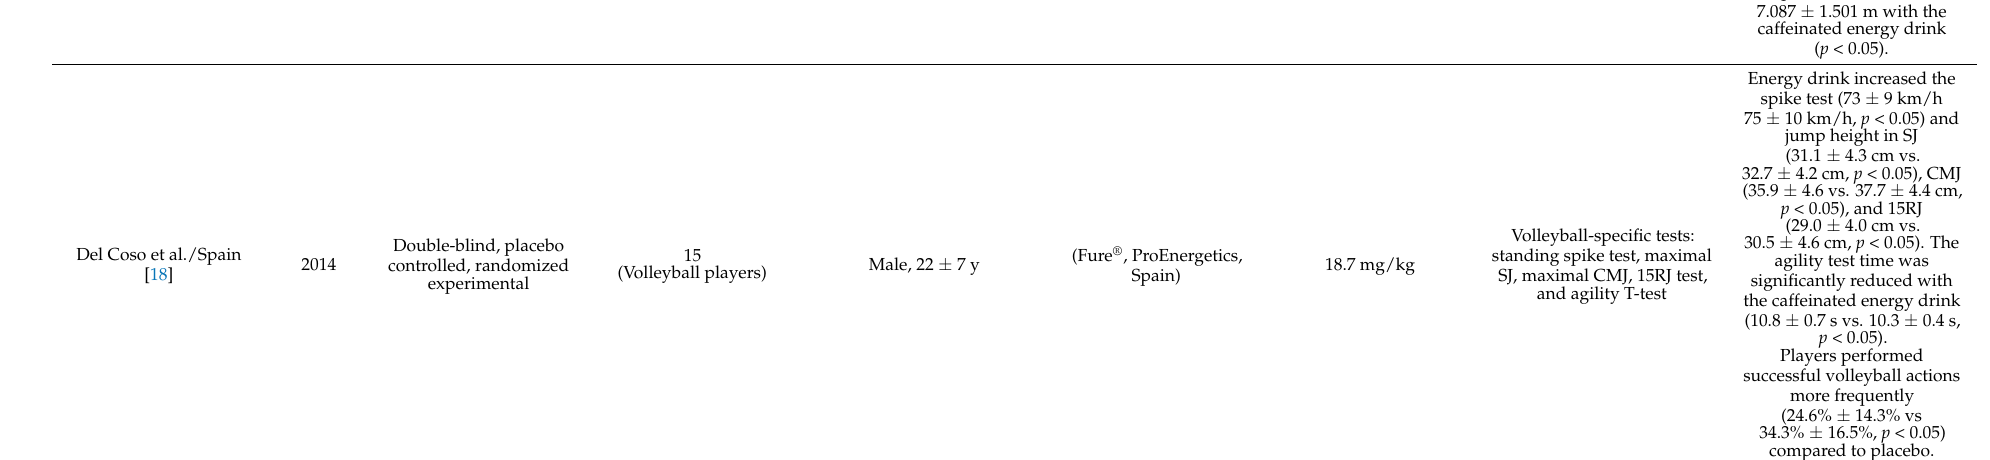
Volleyball-specific tests: standing spike test,